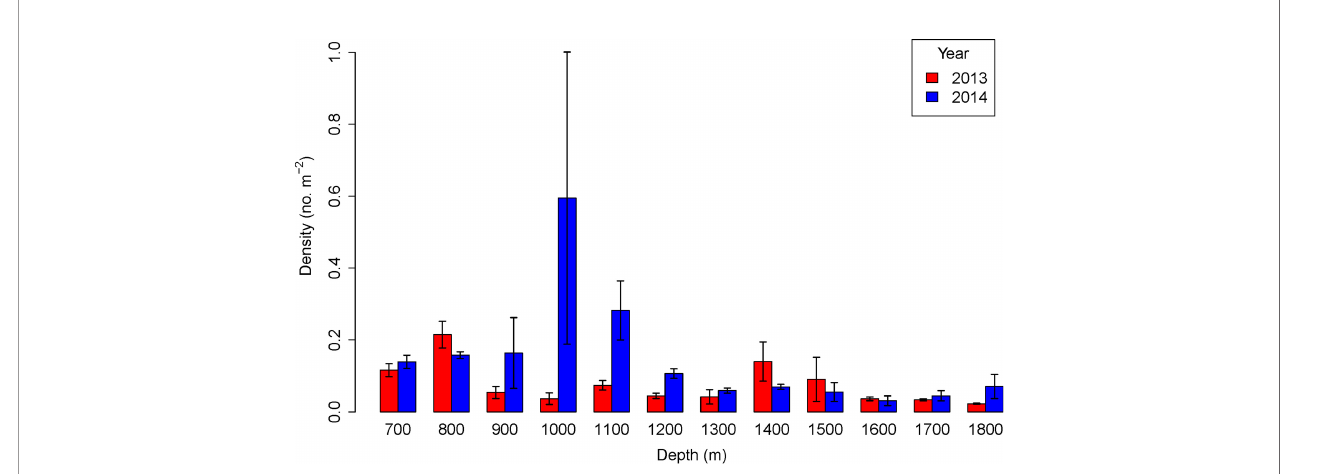
FIGURE 3 | Density variation with depth before (2013) and after (2014) pipeline installation. Error bars represent